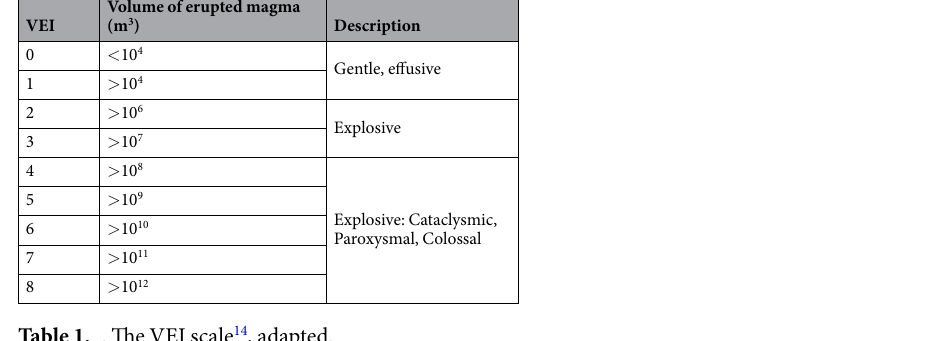
Table 1. . The VEI scale 14 ,